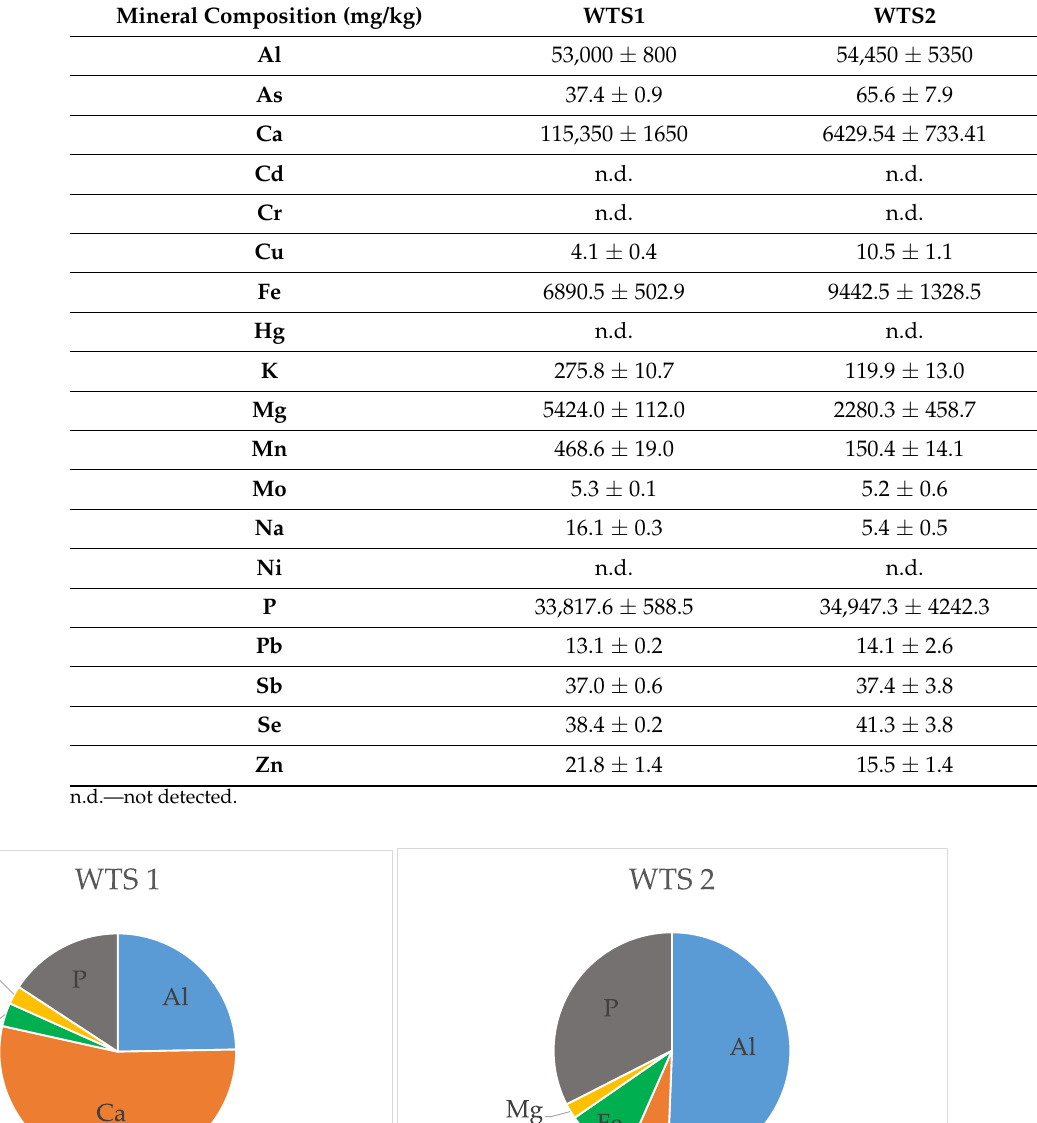
Table 2. Mineral composition of drinking water treatment sludge (WTS) samples. The values presented correspond to the mean of replicates ( X ± σ , n = 2) Mineral Composition (mg/kg) WTS1 WTS2